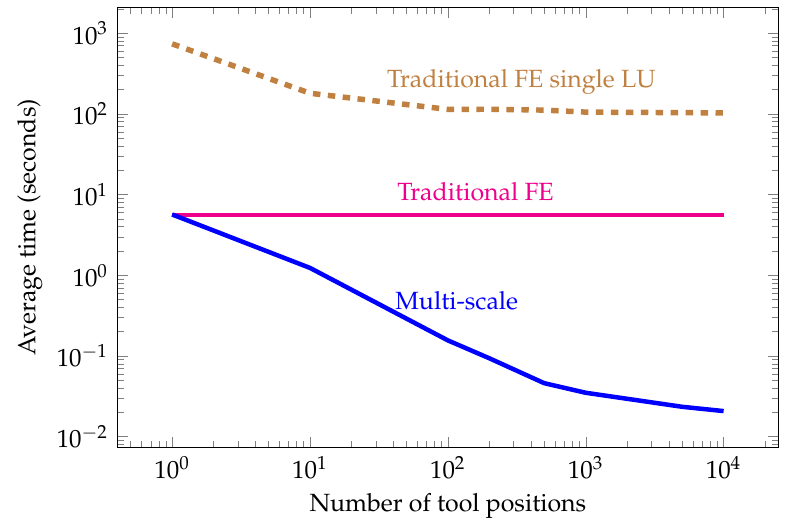
Figure 14. Model problem 2. Average time (in seconds) to solve for one tool position as the number of logging positions varies using (a) a traditional FE approach, (b) a FE approach where we reuse the LU time(seconds) factorization, and (c) our proposed multi-scale method ( number of tool